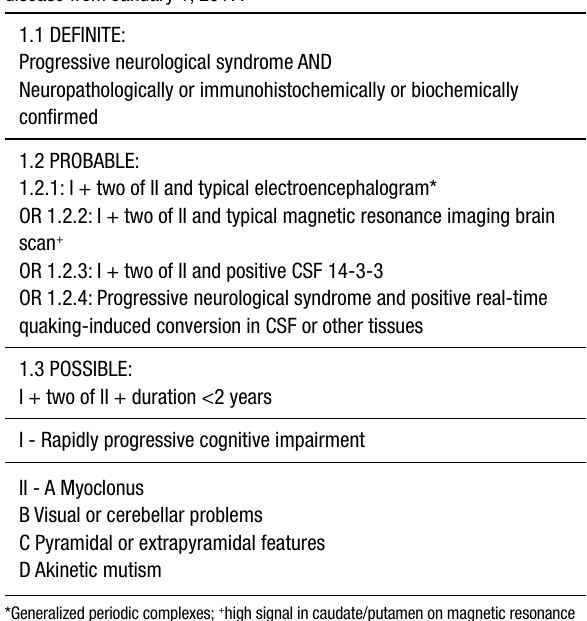
Table 2. Diagnostic criteria for surveillance of sporadic Creutzfeldt-Jakob disease from January 1,